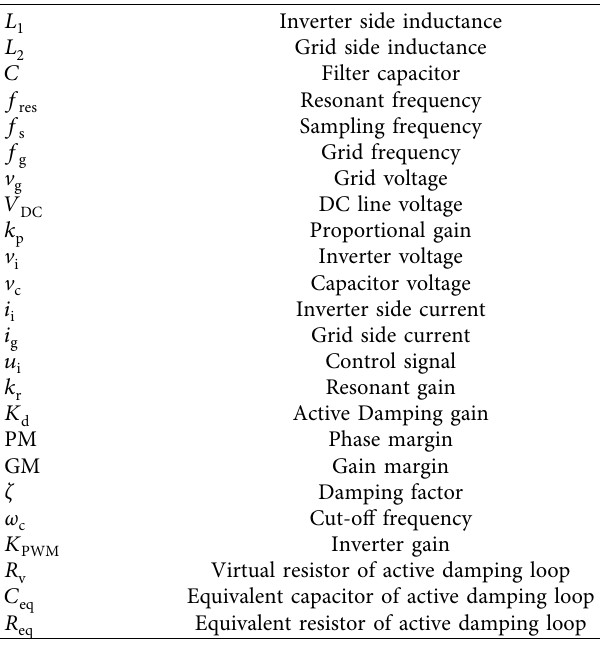
Figure 1: Grid current control scheme of grid connected VSI with active damping by measuring capacitor current. Table 1: Parameter